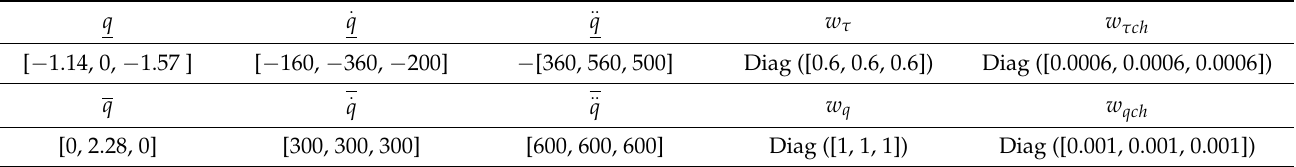
Table 2. Parameter vector and weights in the optimization for trajectory generation.